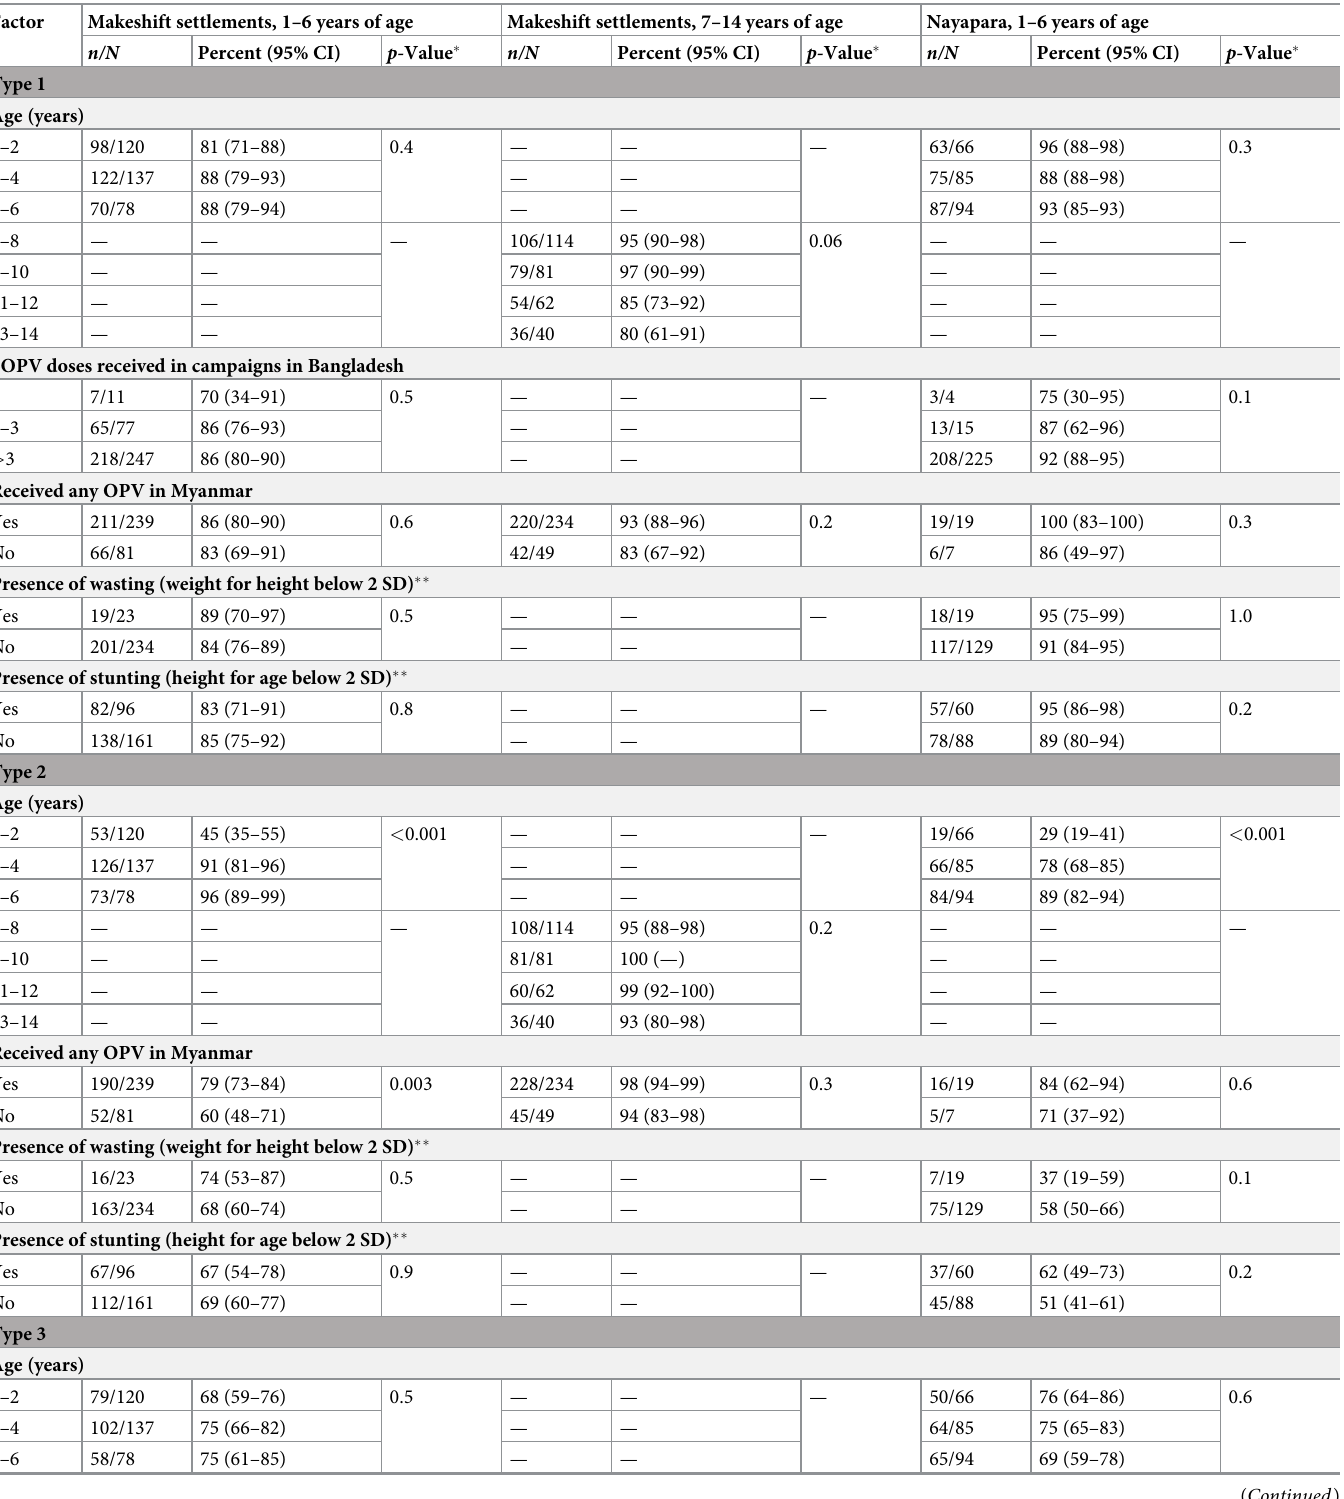
Table 3. Seroprevalence to poliovirus by age group, nutritional status, and vaccination history—Rohingya children, Cox’s Bazar, Bangladesh, April–May